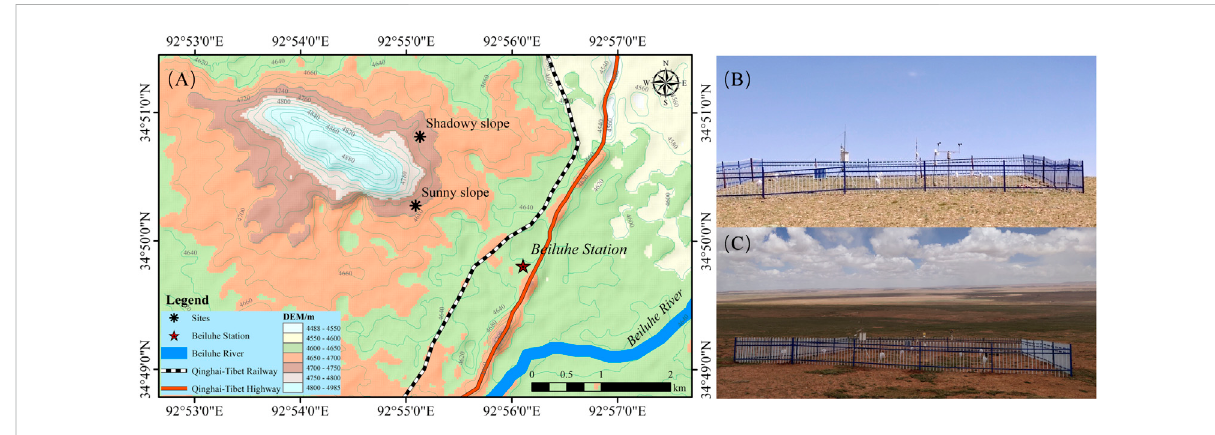
FIGURE 1 Location of sunny (B) and shadowy (C) slopes monitoring sites in the Beiluhe Basin (A)